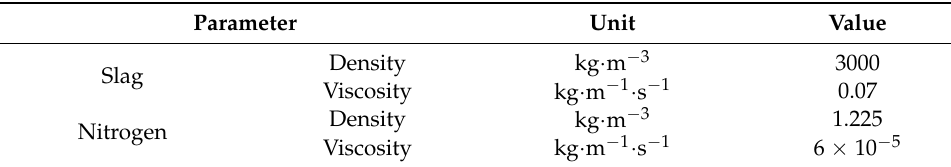
Table 2. Properties of fluids used for CFD